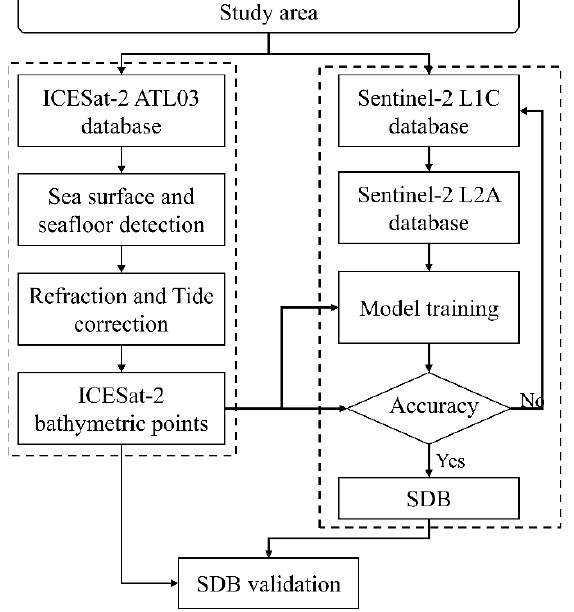
Figure 3. The workflow of shallow water bathymetry combining with ICESat-2 and Sentinel-2.